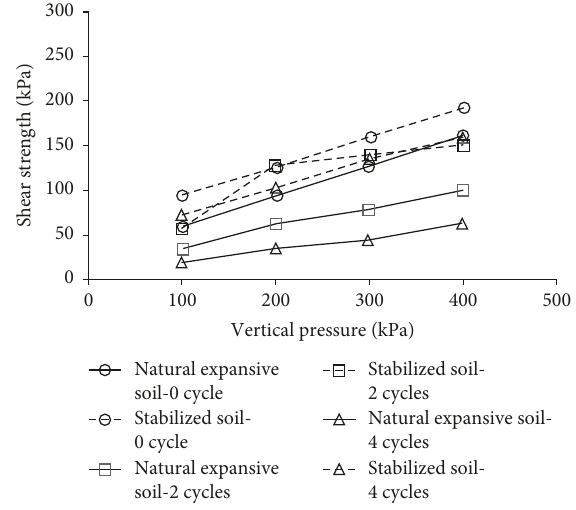
Figure 8: Direct shear strengths for samples with cycles of drying-